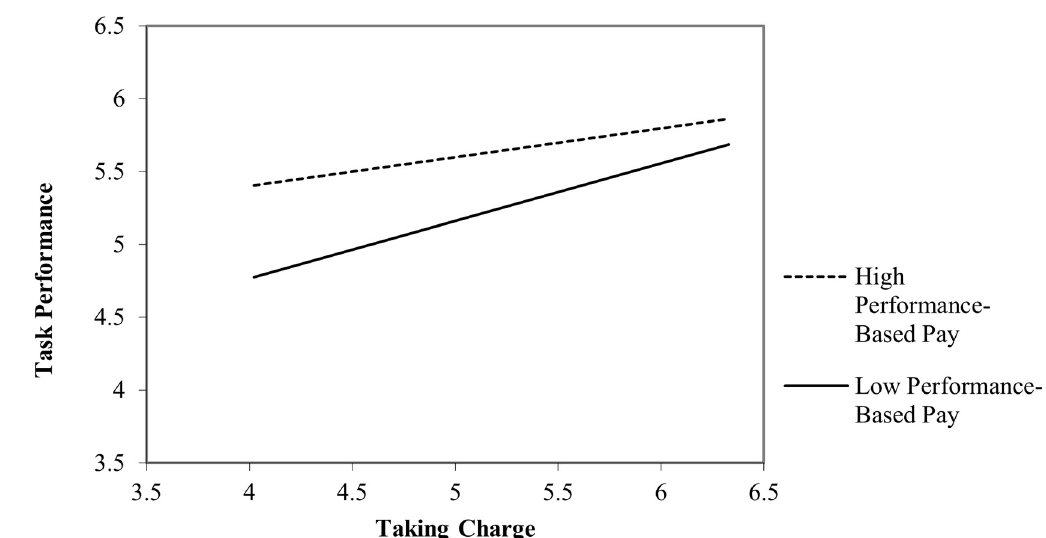
Fig 2. The moderating effect of performance-based pay on the relationship between taking charge and creative performance.